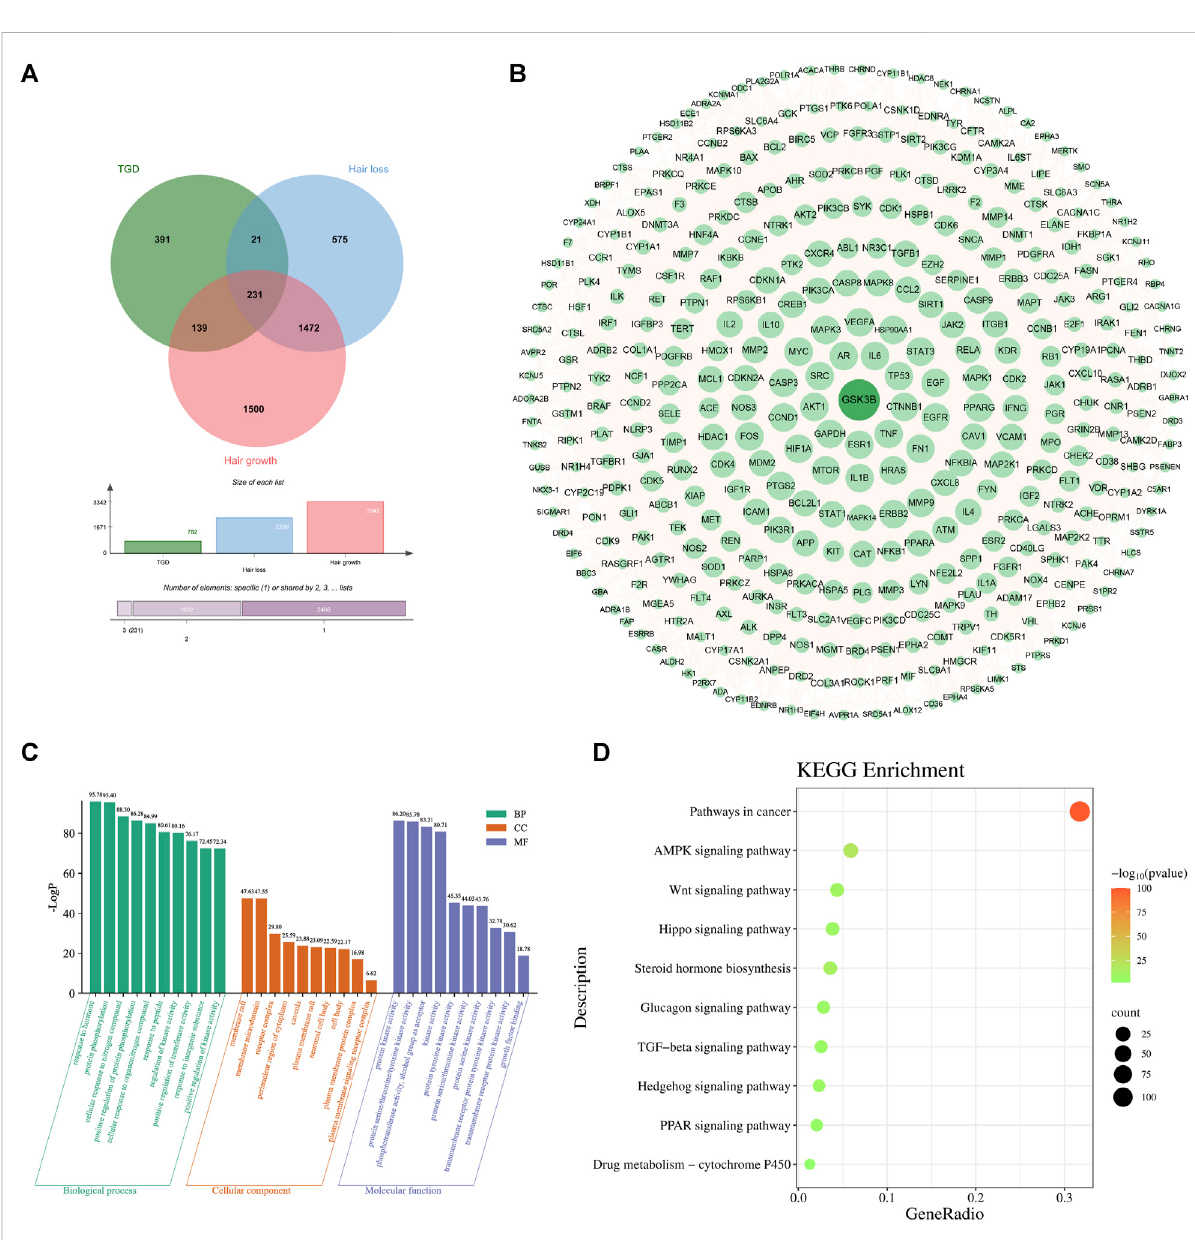
FIGURE 4 Second-dimensional network constructed by bioactive components detected from TGD in alopecia. (A) Venn diagram of diseases and bioactive compounds cross-targets. (B) Protein-protein interaction network. (C) The top 10 signi fi cantly enriched of BP, CC, and MF of GO analysis. The X -axis represents the pathway enrichment in GO category. The Y -axis shows the signi fi cant enrichment counts. (D) The KEGG pathway enrichment analysis of key